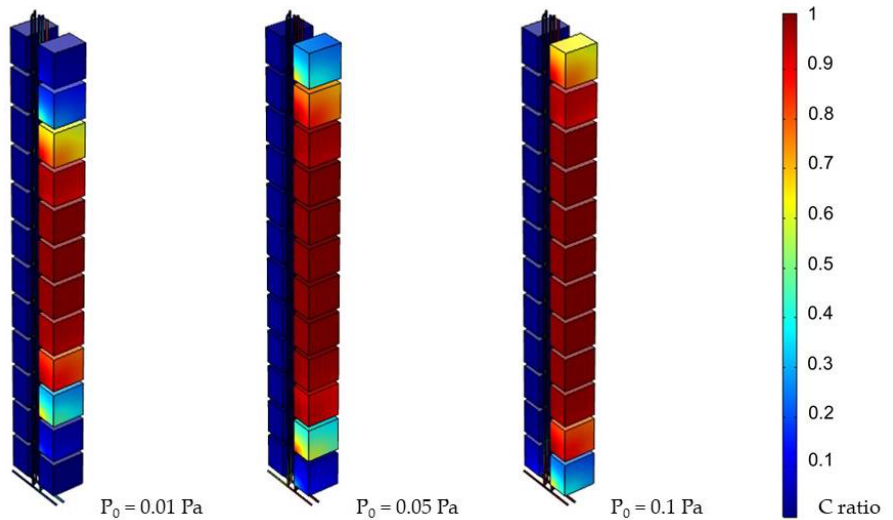
Figure 8. Simulation results for various P 0 (day 3, 1000 ppm).